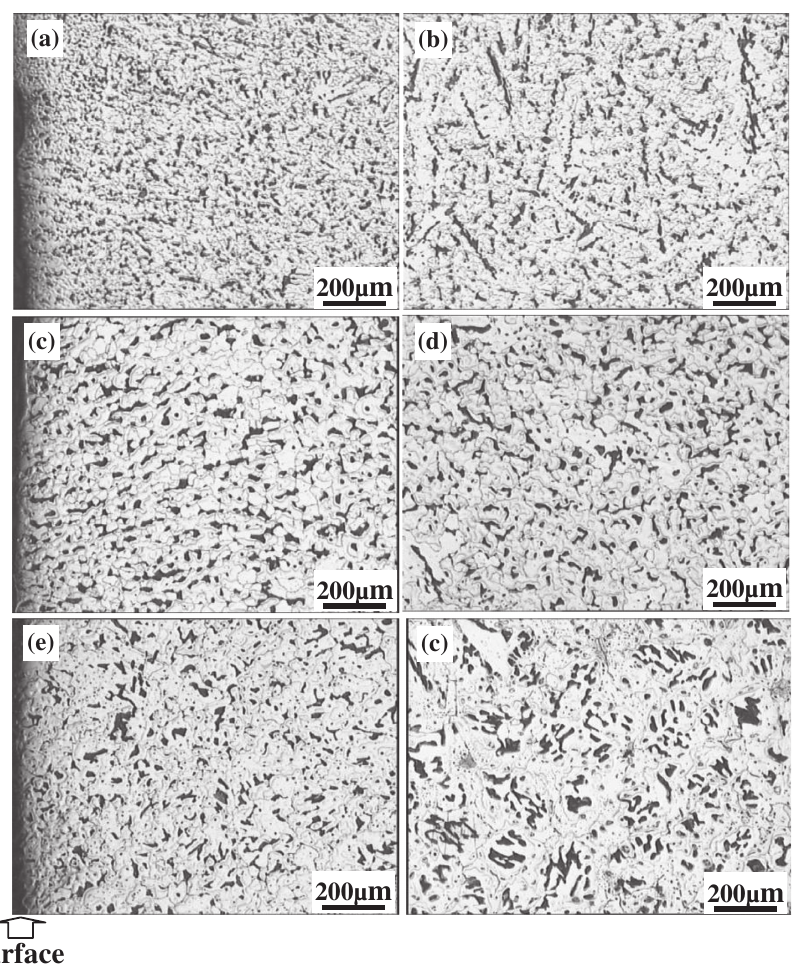
Figure 5: OM photos of the cross section of as-cast sample 2: near the surface (a) and at the center (b) with the thickness of about 2mm, near the surface (c) and at the center (d) with the thickness of about 26mm, and near the surface (e) and at the center (f) with the thickness of about 37mm.